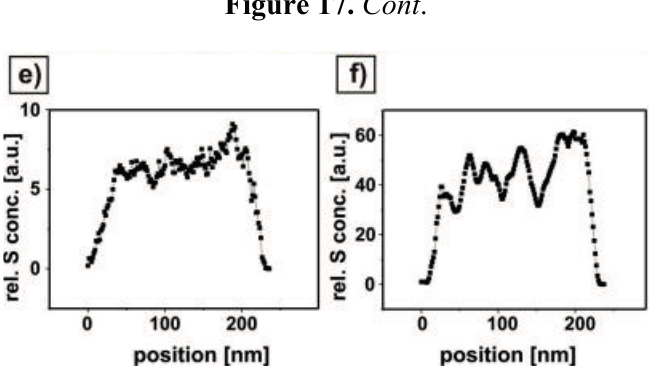
Figure 18. 1 H NMR spectra of P3HT-PCBM: ( a ) combined rotation and multiple